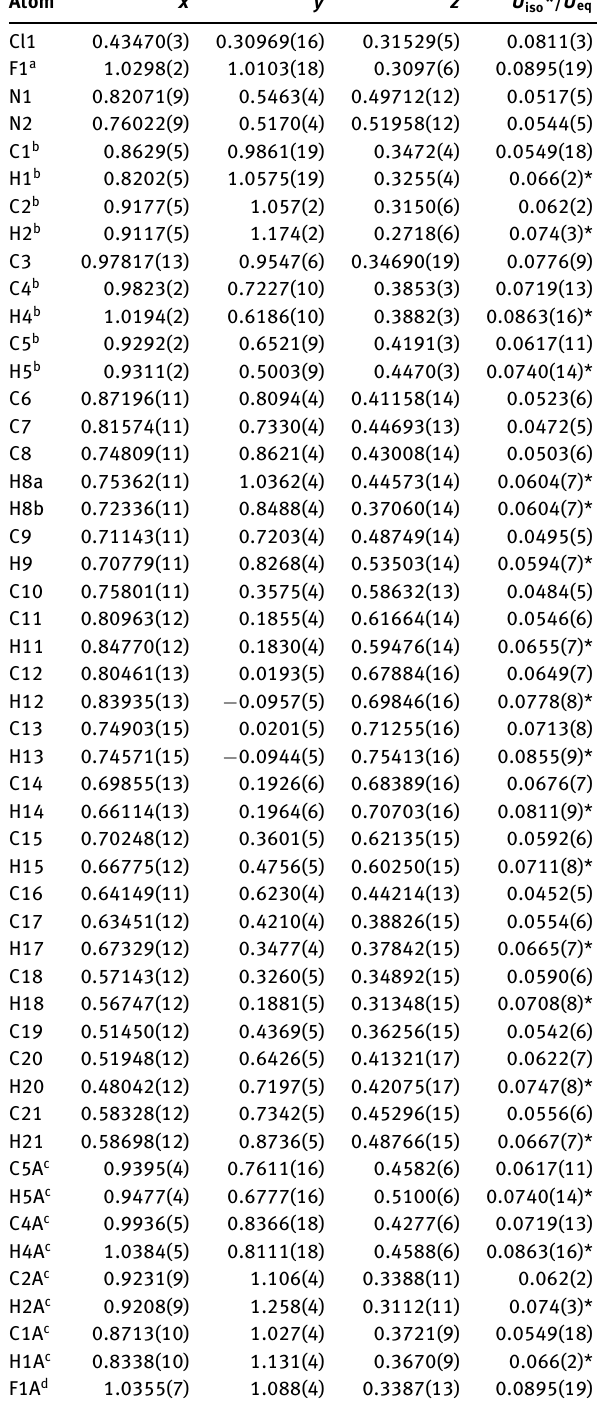
Table 2: Fractional atomic coordinates and isotropic or equivalent isotropic displacement parameters (Å 2